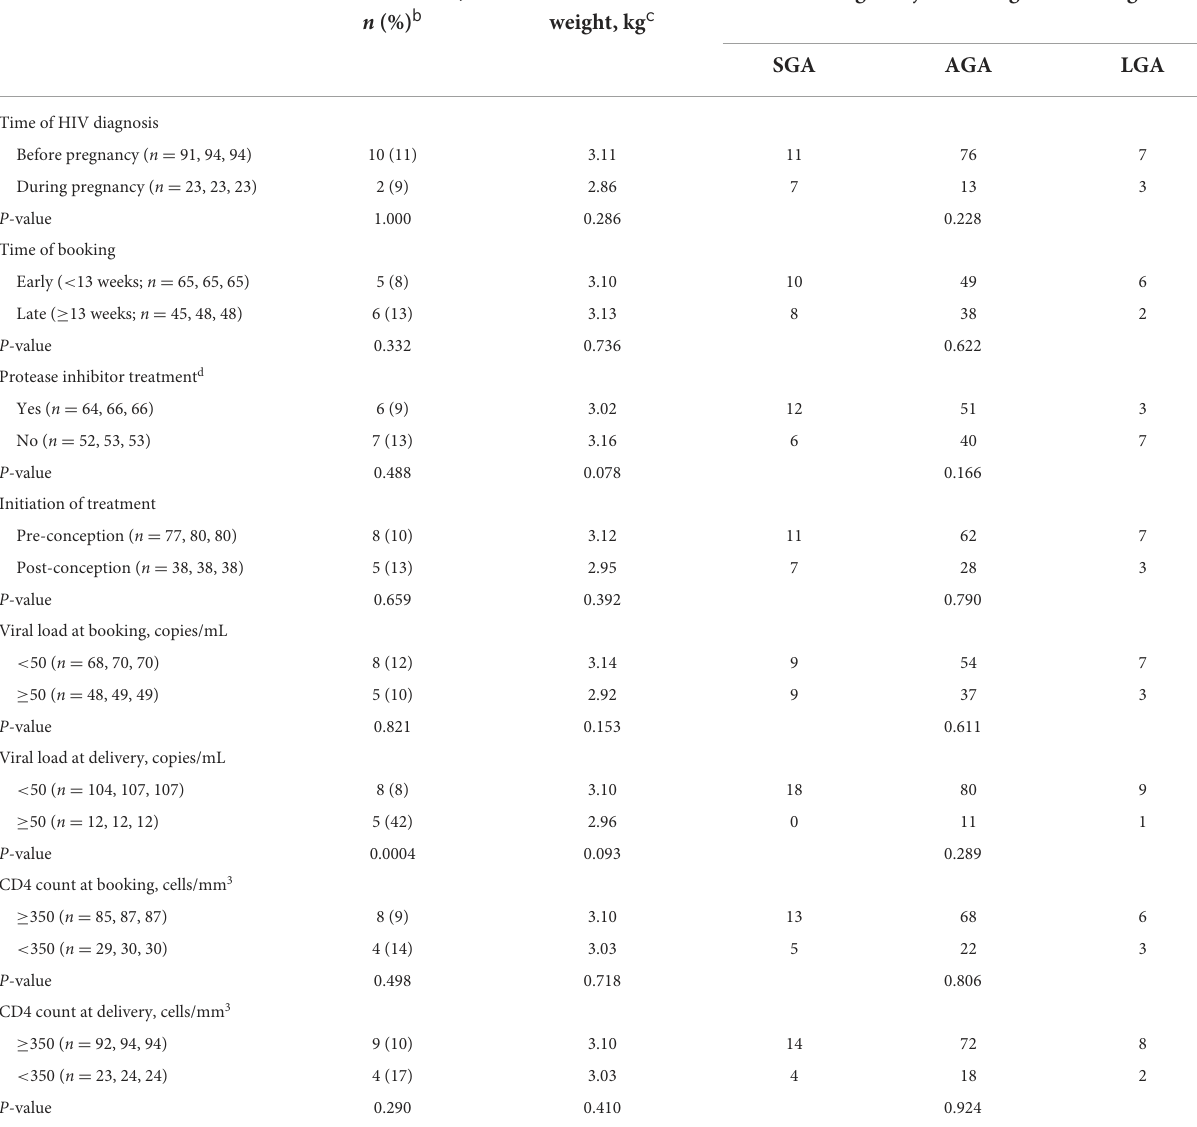
TABLE 5 Associations between HIV and treatment characteristics, and birth outcomes. Characteristic a Preterm births,